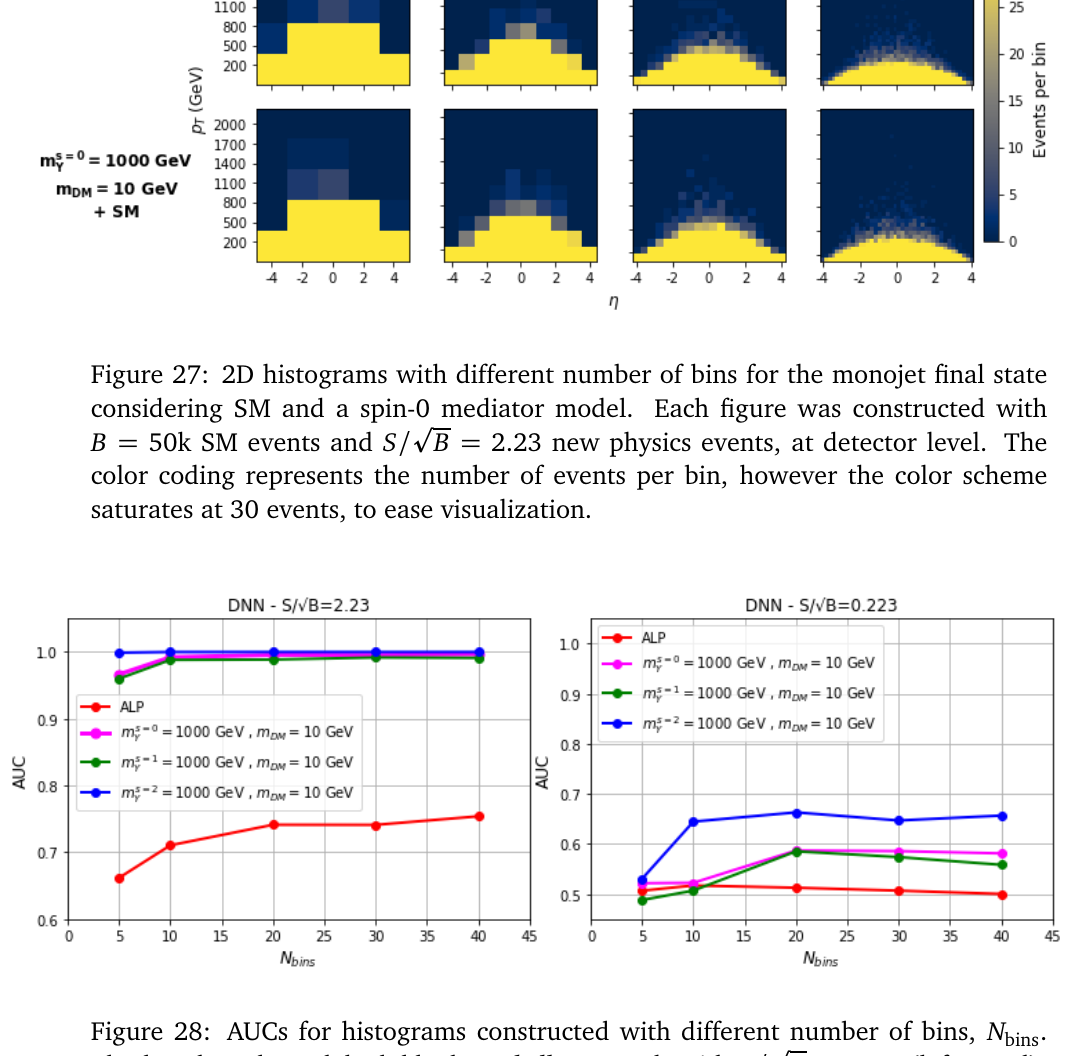
. (cid:112) bins B = 2.23 (left panel),